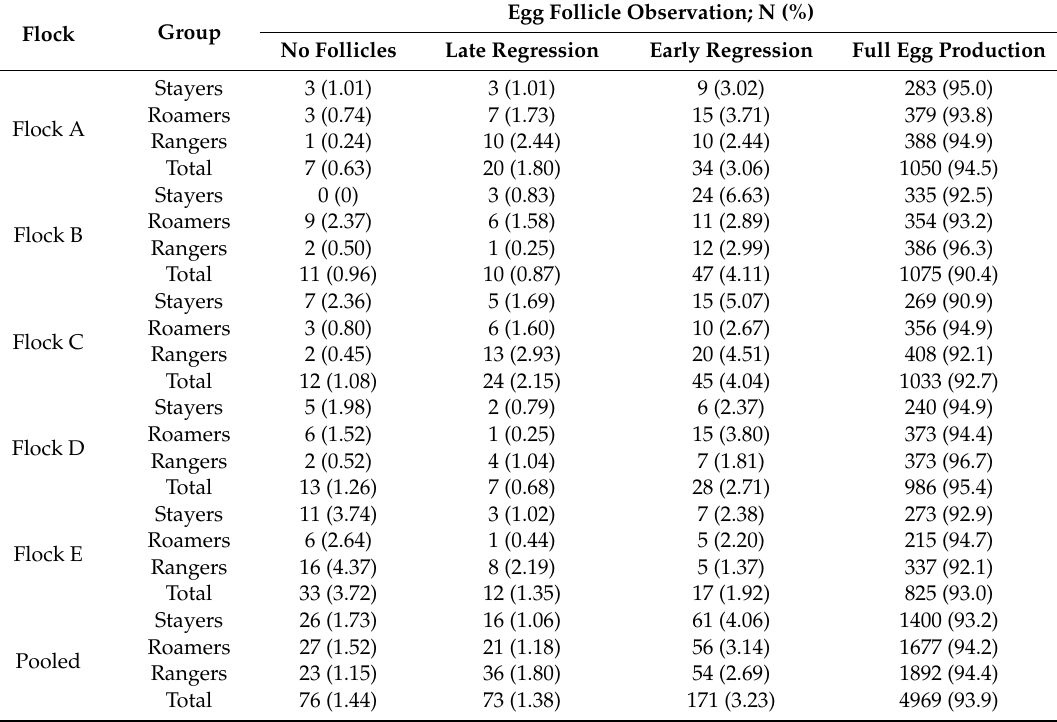
Table 5. Descriptive of hens with di ff erent egg follicle characteristics of stayers, roamers and rangers in free range laying hens at 74 weeks of age in the five flocks. The numbers in brackets present the percentage proportion of